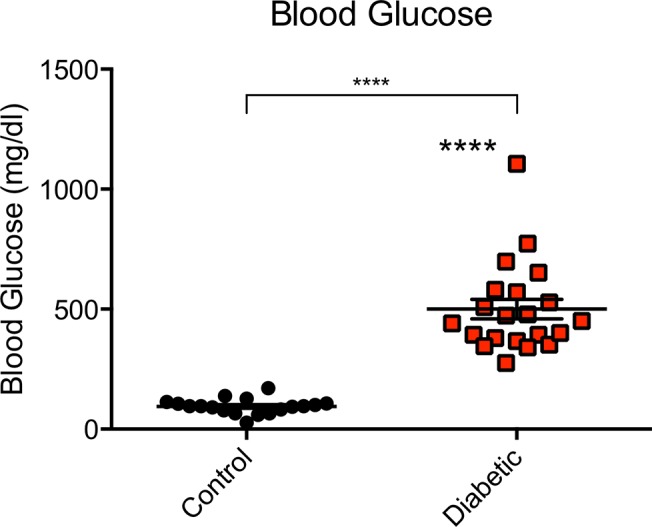
Diabetic dogs exhibit severe hyperglycemia.Blood glucose levels of control and diabetic dogs. Blood glucose in the range of 65–112 mg/dl is considered clinically normal. Results expressed as mean ± SEM for 18 control and 21 diabetic dogs. ****p<0.0001, controls vs. diabetics.